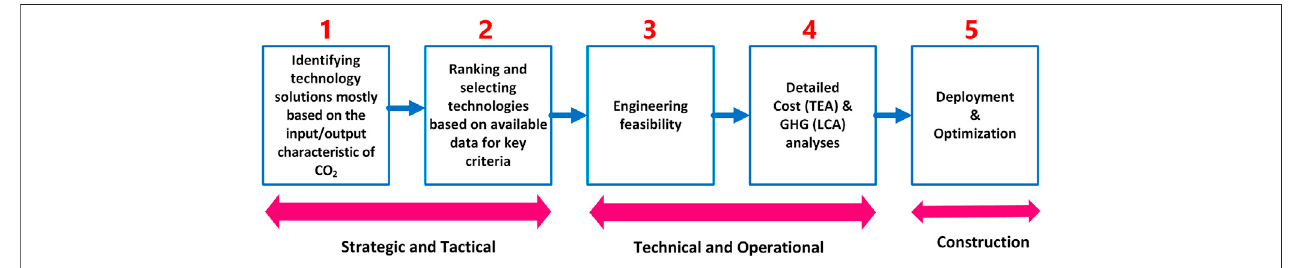
FIGURE 1 | Proposed fi ve-step process to identify, assess, and optimize suitable CCTs among different options and fi nd current technology gaps.